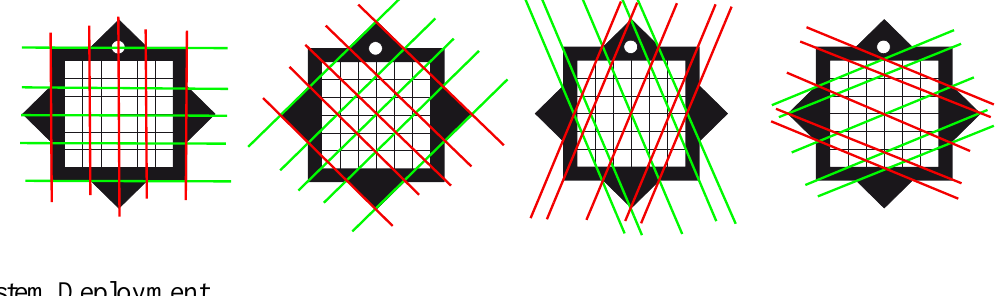
Figure 2. Different directions of parallel lines defined by the marker